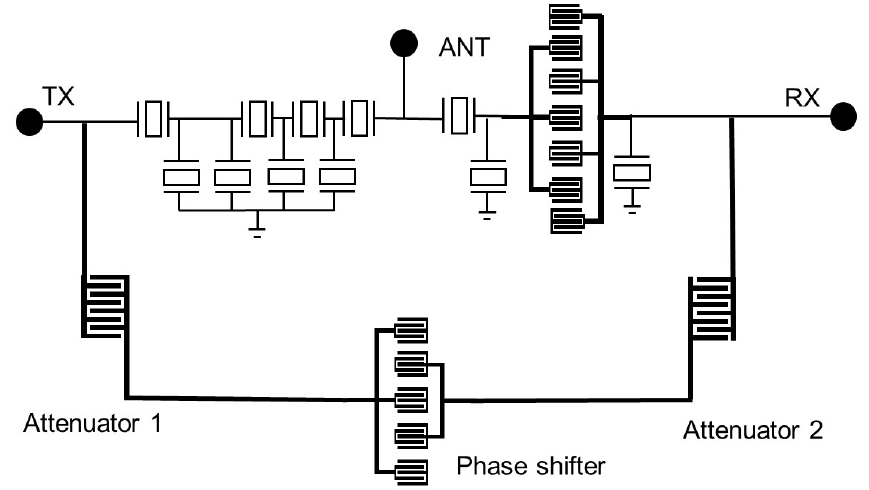
Figure 9. The structure of phase canceling circuit.